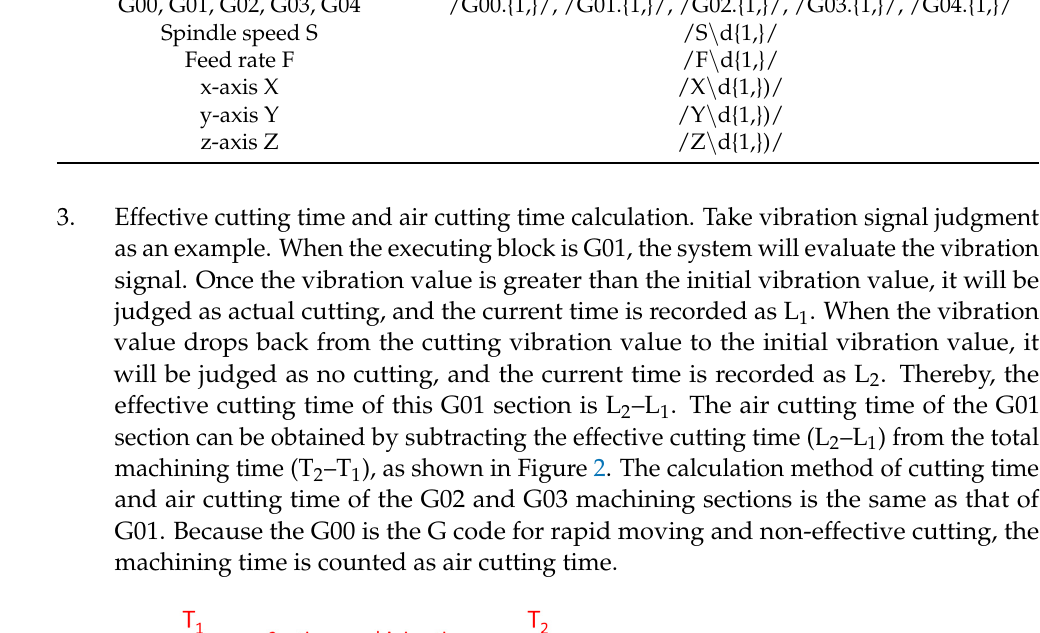
Table 1. Regular Expression characteristics.